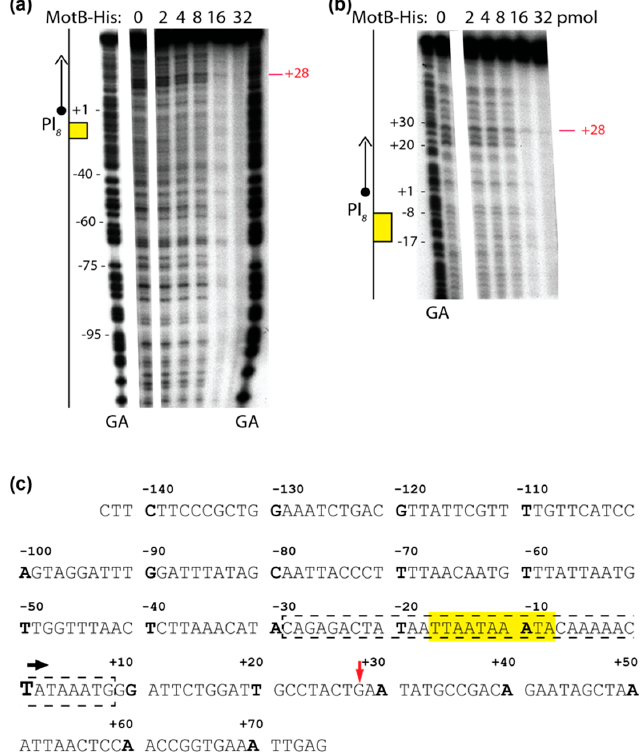
Figure 4. DNase I footprint of MotB on Pl 8 promoter DNA. The 5’- 32 P labeled DNA surrounding the Pl 8 promoter (positions − 143 to +75; 0.05 pmol DNA (10.9 pmol total bp), top labeled) was incubated with the indicated amount of MotB-His and treated with DNase I before electrophoresis on a 5% ( w / v ) polyacrylamide, 7 M urea denaturing gel. Footprints in ( a , b ) contain the same samples; however, for ( b ) samples were electrophoresed longer to better resolve the downstream region of the DNA. GA lanes represent G + A ladder. To the left of each gel, a schematic of the Pl 8 promoter region is shown with the T4 late promoter TATA box depicted in yellow and the +1-transcriptional start site indicated by the circular arrow head. Footprints are representative of two independent replicates. Nontemplate sequence ( c ) of the Pl 8 promoter ( − 143 to +75) with the TATA box highlighted in yellow, the 37 bp P8 oligo used for gel shift assays indicated by the dashed box, the +1-transcriptional start site indicated by the black arrow and larger font, and the +28 position indicated by the red arrow.